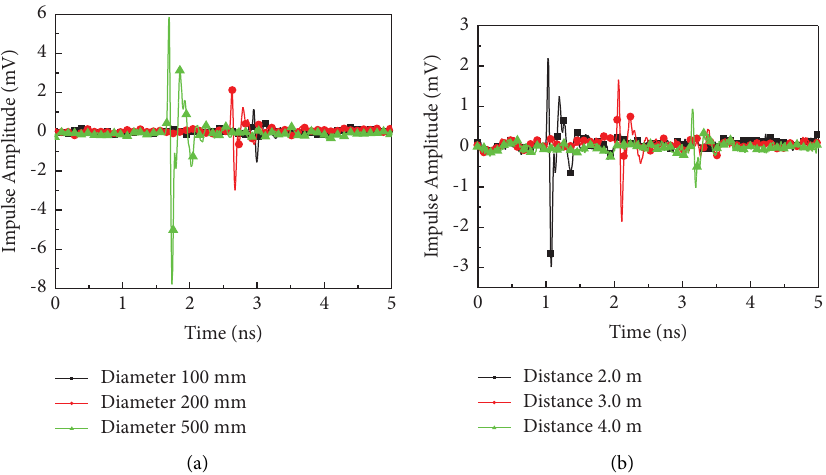
Figure 5: Time domain echo response of calibration sphere. (a) Time domain echo of diferent size calibration sphere and (b) time domain echo of calibration sphere at diferent distances.